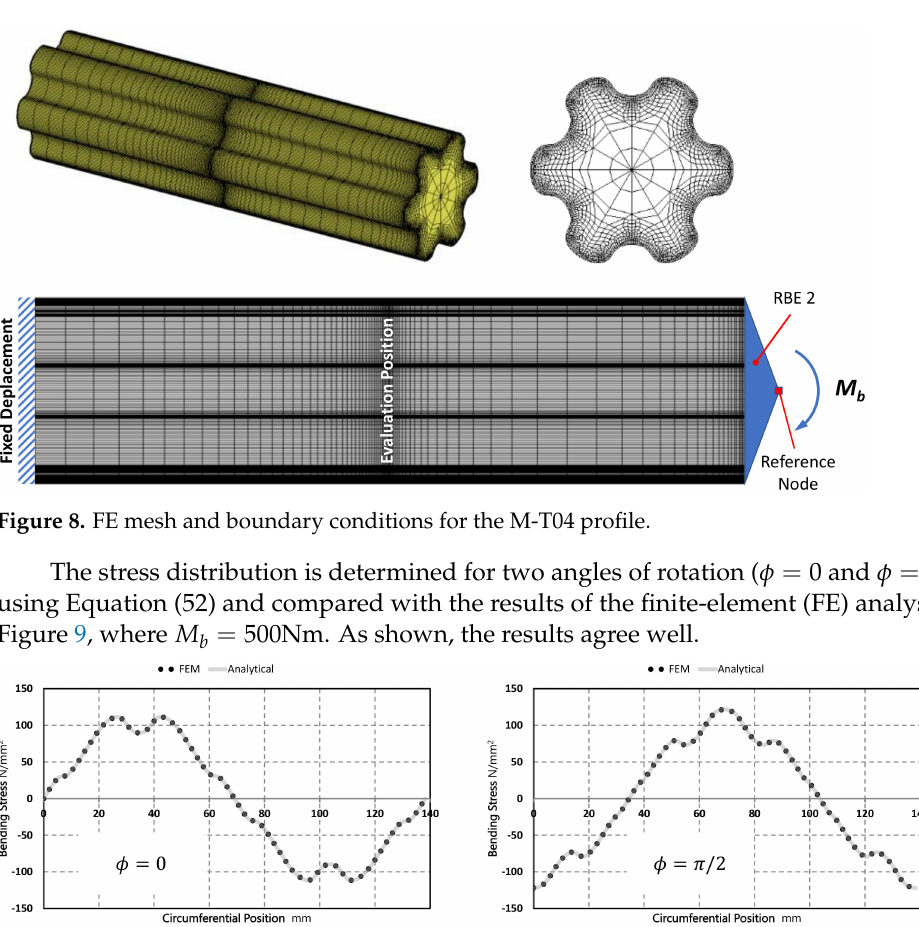
Figure 9. Distribution of the bending stresses on the M-T04 profile for two rotation angles: FEM results and analytical solution based on Equation (52).